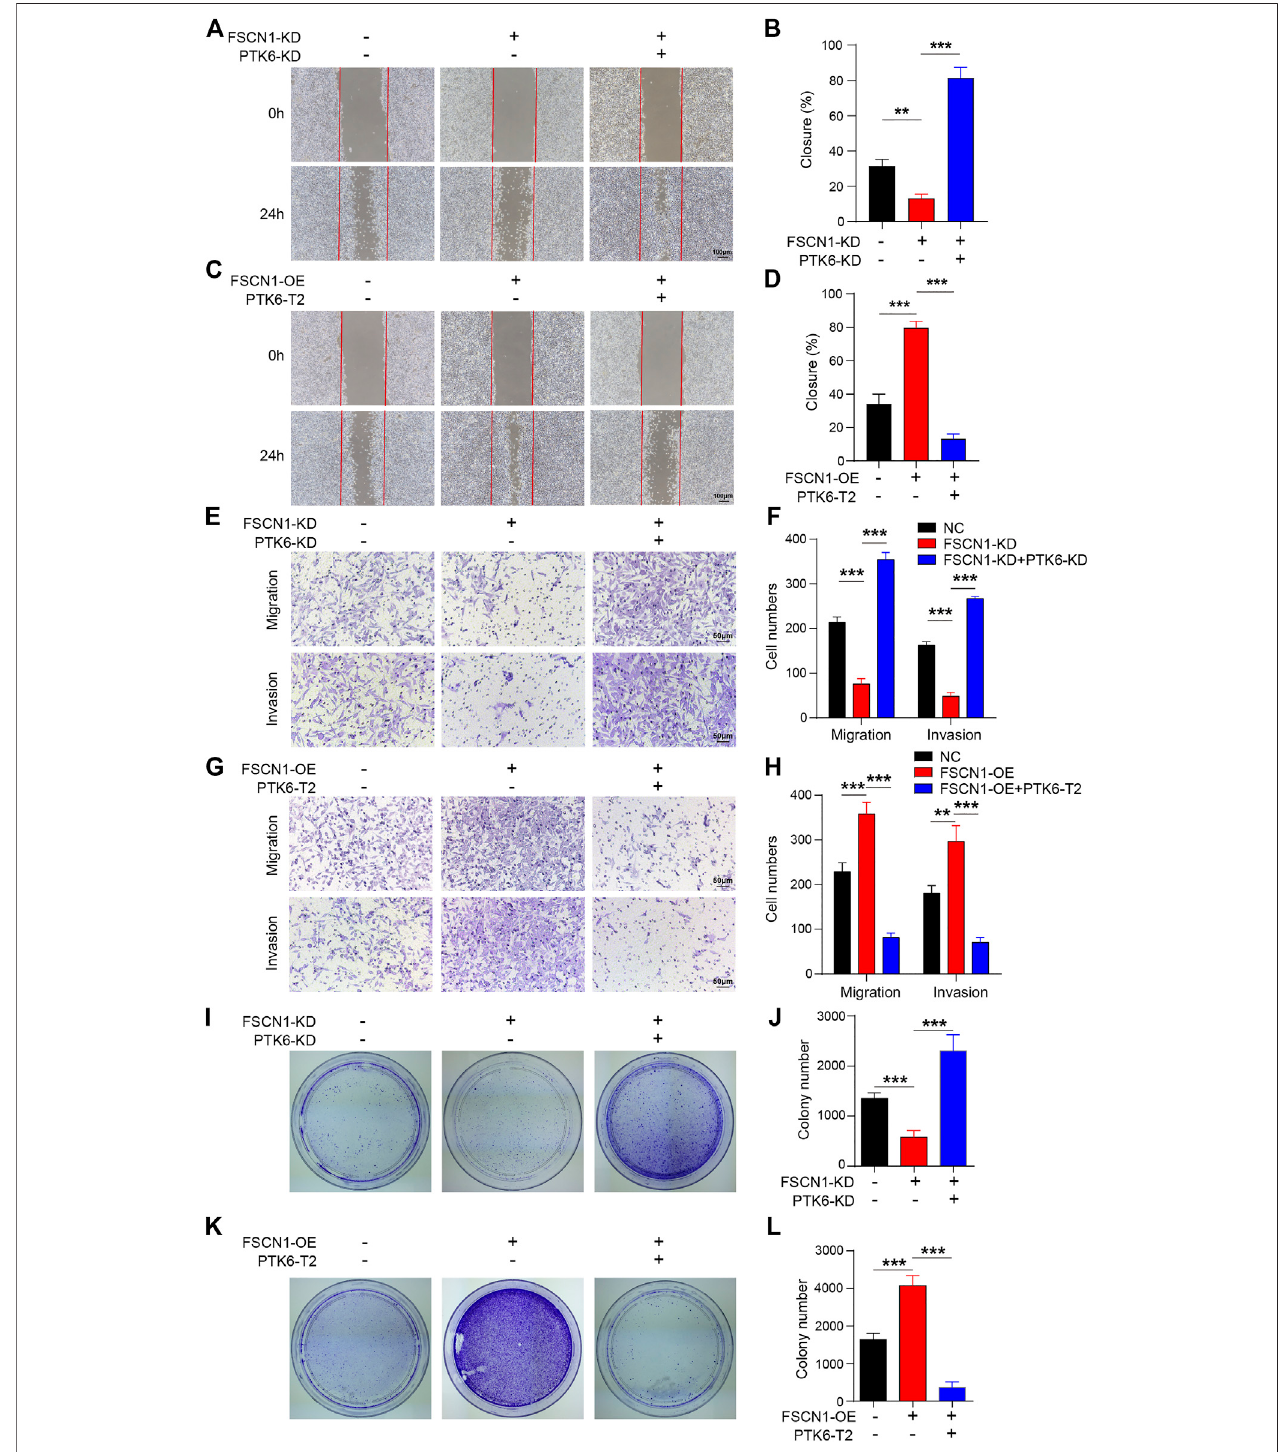
FIGURE 5 | PTK-T2 inhibits ECA-109 migration and invasion. (A) The scratch test was performed using ECA-109 cells expressing NC, FSCN1-KD, and FSCN1- KD + PTK6-KD as indicated. (B) Statistical analysis of A. n = 3 per group, ** p < 0.01, *** p < 0.001. (C) The scratch test was performed using ECA-109 cells expressing NC, FSCN1-OE, and FSCN1-OE + PTK6-T2 as indicated. (D) Statistical analysis of C. n = 3 per group, *** p < 0.001. (E) Transwell and Matrigel tests were performed using ECA-109 cells expressing NC, FSCN1-KD, and FSCN1-KD + PTK6-KD as indicated. (F) Statistical analysis of E. n = 3 per group, *** p < 0.001. (G) The TranswellandMatrigeltestswereperformedusingECA-109cellsexpressingNC,FSCN1-OE,andFSCN1-OE+PTK6-T2asindicated. (H) StatisticalanalysisofG.n=3 per group, ** p < 0.01, *** p < 0.001. (I) Colony formation of ECA-109 cells expressing NC, FSCN1-KD, and FSCN1-KD + PTK6-KD, as indicated, were performed. (J) Statistical analysis of I. n = 3 per group, *** p < 0.001. (K) Colony formation of ECA-109 cells expressing NC, FSCN1-OE, and FSCN1-OE + PTK6-T2 as indicated were performed. (L) Statistical analysis of K. n = 3 per group, *** p < 0.001.